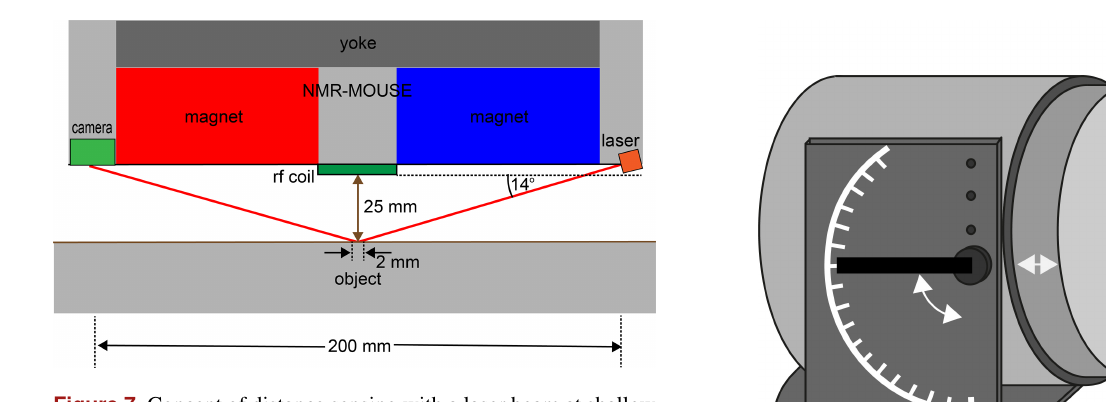
Figure 7. Concept of distance sensing with a laser beam at shallow incidence. If the alignment angle of the reflecting plane changes by 0.2 ◦ , the reflected laser beam is displaced from the center of the detector camera by 4mm.